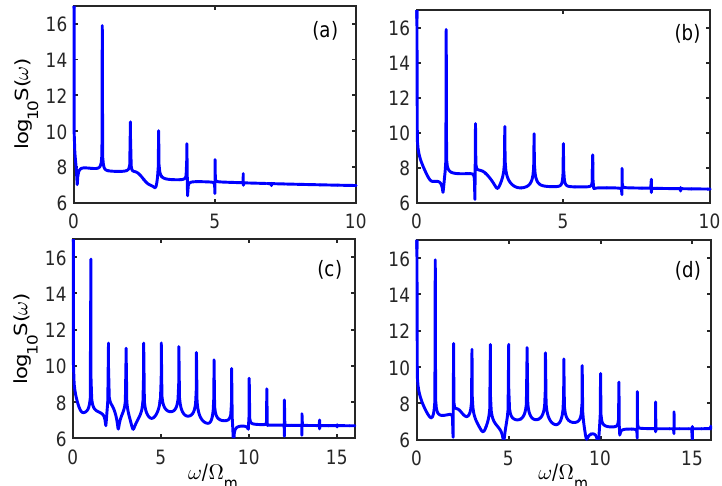
Figure 3. The high-order sideband spectral output from the optomechanical system in the presence of the two-level atoms are shown with various charge numbers n : ( a ) n = 1; ( b ) n = 2; ( c ) n = 3; and ( d ) n = 4. The other parameters are the same as those in Figure 2.